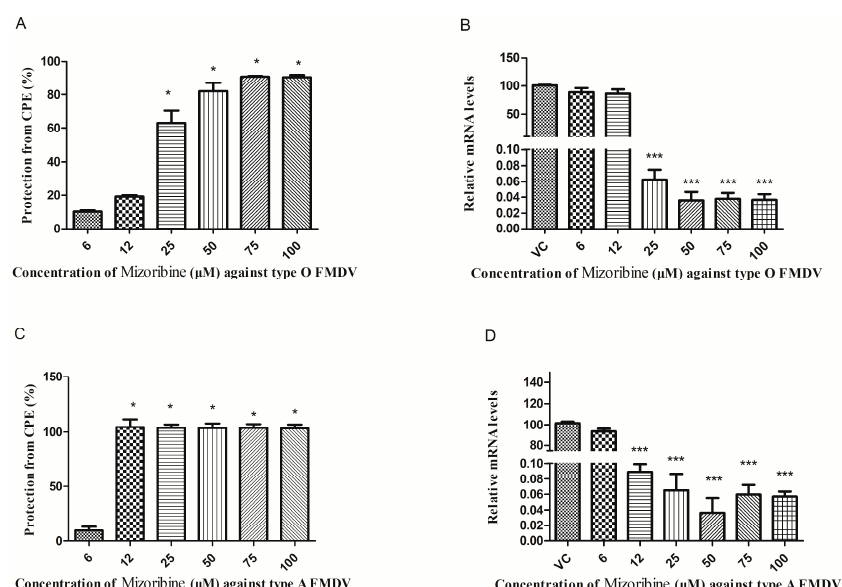
Figure 2. Anti-foot-and-mouth disease (FMD) virus activity of mizoribine in IBRS-2 cells. Confluent IBRS-2 cells infected with 100 TCID 50 ( A , B ) O/MY98/BY/2010 and ( C , D ) A/GD/MM/2013, were exposed to different concentrations of mizoribine for 48 hr. “VC” (virus control group) represents those cells treated with 1% DMSO without mizoribine. ( A , C ) Cell viability was measured using MTS assay. Results are expressed as the mean ± SD from three experiments. ( B , D ) The supernatants were used for viral RNA quantification using qPCR. The expression values relative to that of β -actin were calculated using the 2 −ΔΔ Ct method. CPE, cytopathic effect. Statistically significant differences are indicated by asterisks (* p ﹤ 0.05, *** p ﹤ 0.001). The transcription of FMDV mRNA was significantly reduced with 25, 50, 75, and 100 μ M mizoribine treatments relative to the DMSO control group (Figure 2B). Consistent with mRNA expression, immunofluorescence assay (IFA) revealed that mizoribine inhibited the expression of FMDV protein in a dose-dependent manner (Figure 3). The concentration of 75 μ M, which showed more protection against CPE than other concentration, was chosen for the further study.